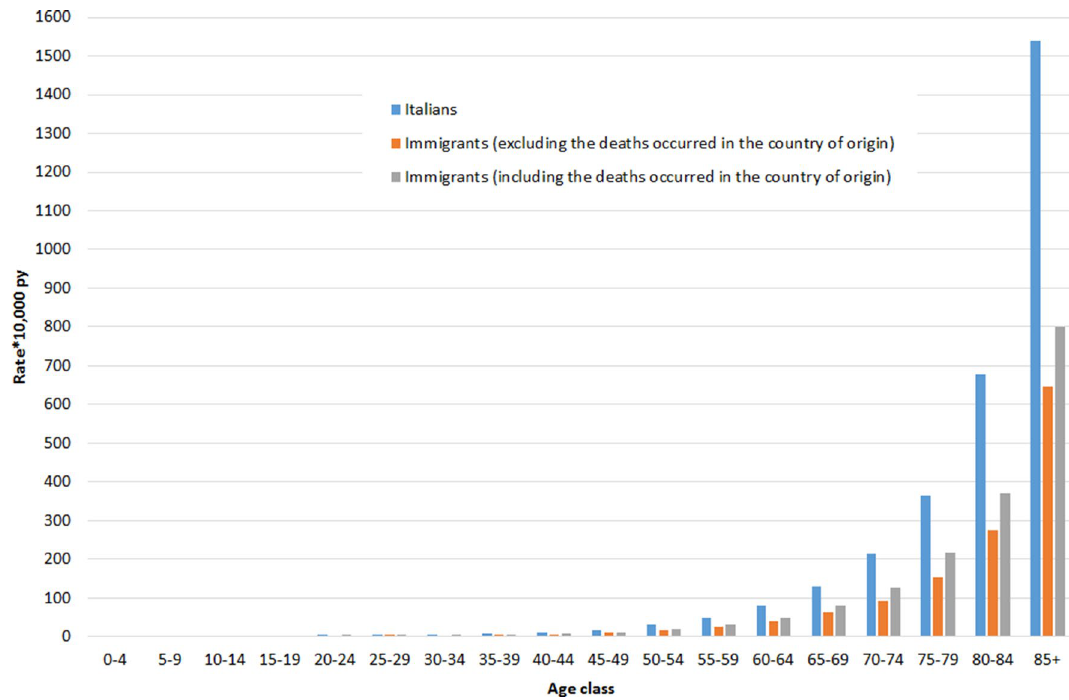
Figure 1. Age-specific mortality rates*10,000 person years among men resident in Italy, by citizenship and source of data. Istat,